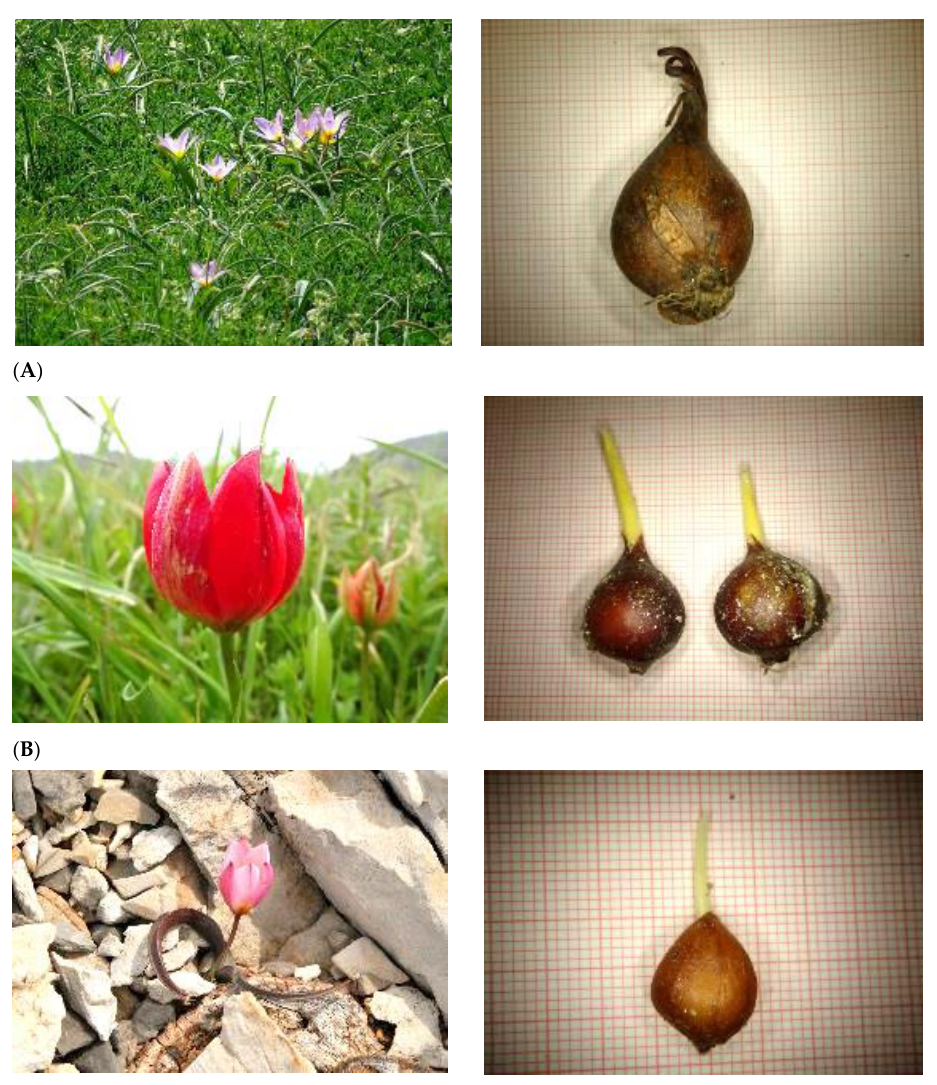
Figure 1. Wild-growing Greek tulips endemic to the island of Crete and individual bulbs collected for ex situ conservation in the frame of TULIPS.GR: ( A ) Tulipa bakeri and ( B ) T. doerfleri assessed as Critically Endangered [27], and ( C ) T. cretica (photo: V. Papiomytoglou) assessed as Endangered [27].